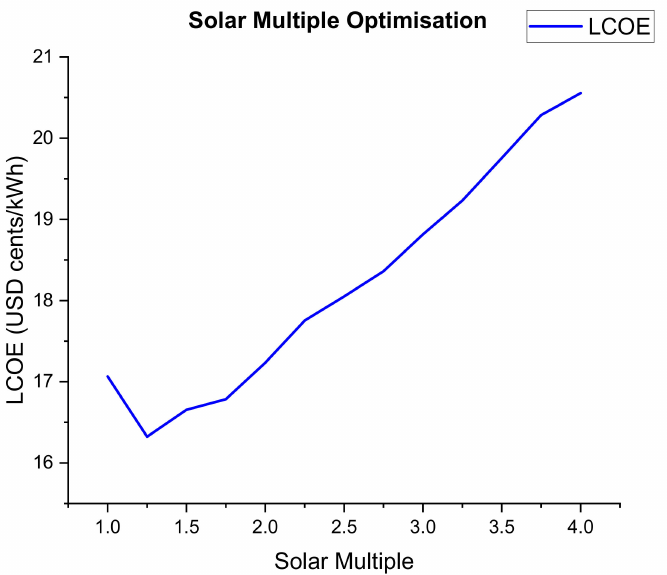
Figure 20. Solar multiple optimisation.